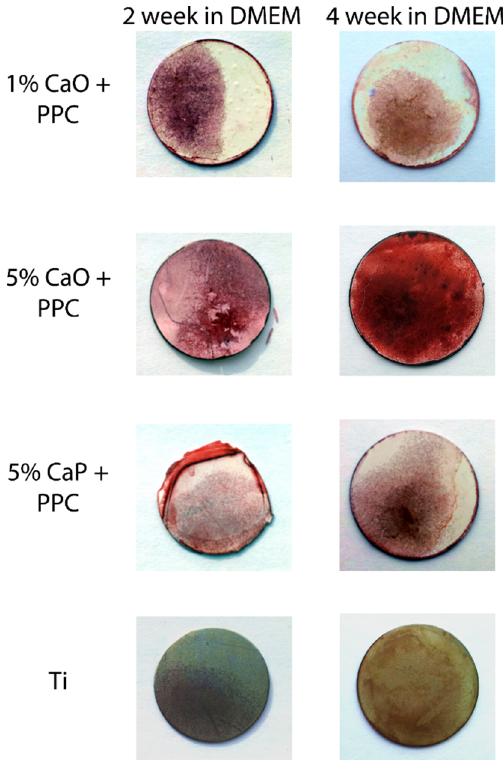
Figure 10. Biomineralization assay using Alizarin Red staining after two weeks and four weeks of proliferation and differentiation. Alizarin Red staining suggested even though all of the surfaces showed increased signs of mineral deposits over time, 5% CaO-containing surfaces exhibited the great degrees of staining after two week and four weeks of proliferation and differentiation. However, conventional titanium showed the least amount of mineral deposits amongst all of the surfaces. (Adapted and modified from [2]).